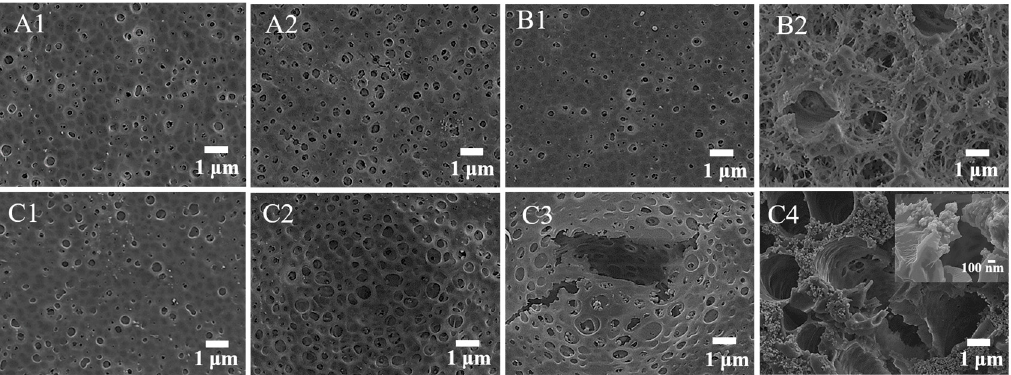
Figure 8. SEM images of films. ( A1 ) PVC before irradiation, ( A2 ) PVC after irradiation; ( B1 ) TiO 2 /PVC before irradiation, ( B2 ) TiO 2 /PVC after irradiation; ( C1 ) La 3+ /TiO 2 /PVC before irradiation, La 3+ /TiO 2 /PVC after irradiation for ( C2 ) 10 h, ( C3 ) 20 h, ( C4 ) 30 h.